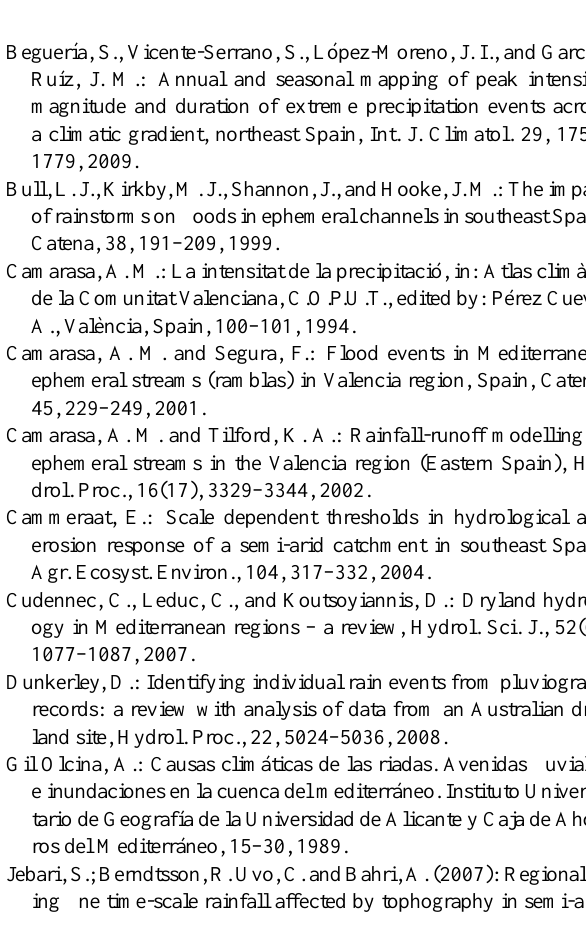
prolonged up to 1 h. After three hours, the persistence of rain values decrease by less than